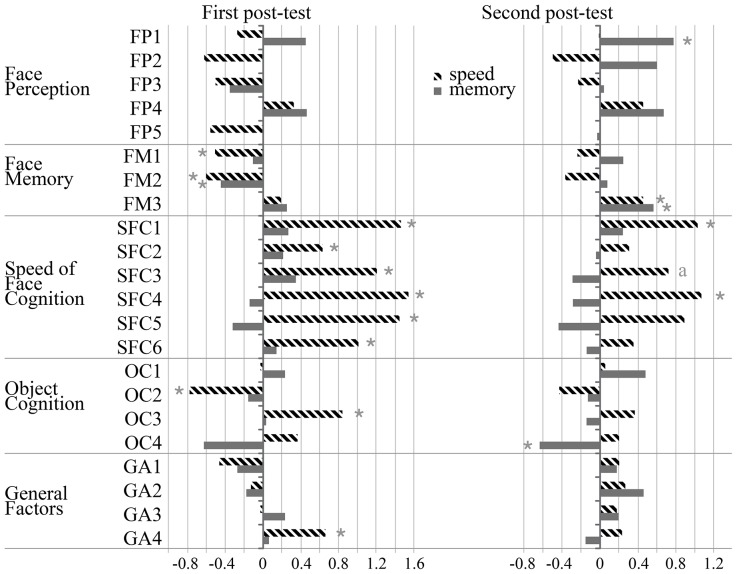
Performance gains from pre-test to first and second post-test as net effect sizes.Bars depict net effect sizes (difference in standardized changes between the experimental and the control group), for the group trained in face memory (solid bars) and in speed of face cognition (pattern filled bars). Statistical significance was tested as interactions (* p<.05; a: p = .052) between group (training vs. control) and occasion (pre- vs. post-test). FP1 – Facial resemblance; FP2 – Sequential matching of part-whole faces – condition part; FP3 – Sequential matching of part-whole faces – condition whole; FP4 – Simultaneous matching of spatially manipulated faces – condition upright; FP5 – Simultaneous matching of spatially manipulated faces – condition inverted; FM1 – Acquisition curve; FM2 – Decay rate of learned faces 1; FM3 – Eyewitness testimony; SFC1 – Recognition speed of learned faces; SFC2 – Delayed non-matching to sample; SFC3 – Simultaneous matching of faces from different viewpoints; SFC4 – Simultaneous matching of upper face-halves – condition aligned; SFC5 – Simultaneous matching of upper face-halves – condition non-aligned; SFC6 – Simultaneous matching of morphs; OC1 – Sequential matching of part-whole houses – condition part; OC2 – Sequential matching of part-whole houses – condition whole; OC3 – Delayed non-matching of houses to sample; OC4 – Simultaneous matching of house morphs; GA1 – Immediate memory; GA2 – Delayed memory; GA3 – General cognitive ability; GA4 – Mental speed.